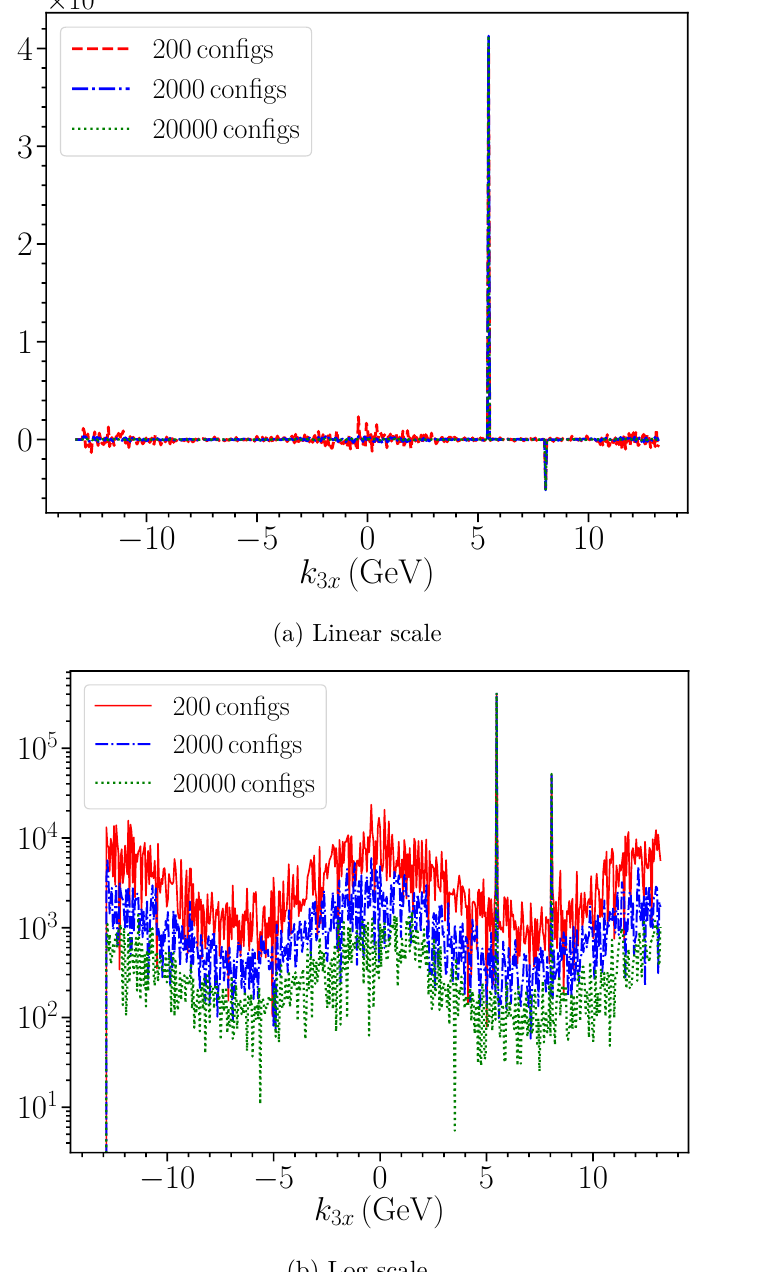
Figure 1. Four-Wilson-line correlator h Tr[ U ( k 1 ) T a U T ( k 2 ) U ( k 3 ) T a U T ( k 4 )] i peaks at k 3 = − k 2 and k 3 = − k 1 . The figures are plotted by choosing k 1 = ( − 8 . 06GeV , 0) and k 2 = ( − 5 . 48GeV , 0) and k 3 = ( k 3 x , 0) is varied along x -direction. With increasing the number of averaging configurations, the peak values are unchanged while values at other momenta are